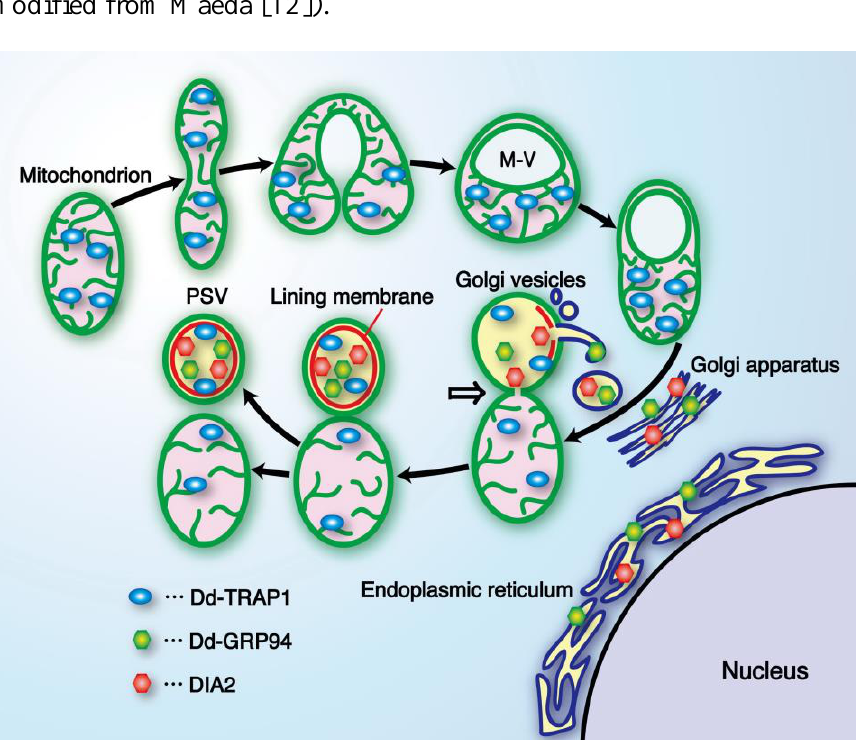
Figure 7. A diagrammatic representation showing formation of the prespore-specific vacuole (PSV) from a mitochondrion and Golgi vesicles. Prior to PSV formation, mitochondria in differentiating prespore cells undergo drastic transformation to form a sort of vacuole (M vacuole), and some Dd-TRAP1 molecules translocate into the M vacuole. Subsequently, Golgi vesicles containing DIA2, Dd-GRP94 and other materials required for PSV formation fuse with the M vacuole, thus resulting in formation of the lining membrane (red) and the internal fibrous structure in the M vacuole. The mitochondrion-PSV complex is eventually twisted at the junction (arrow) and detached to form the respective organelles.